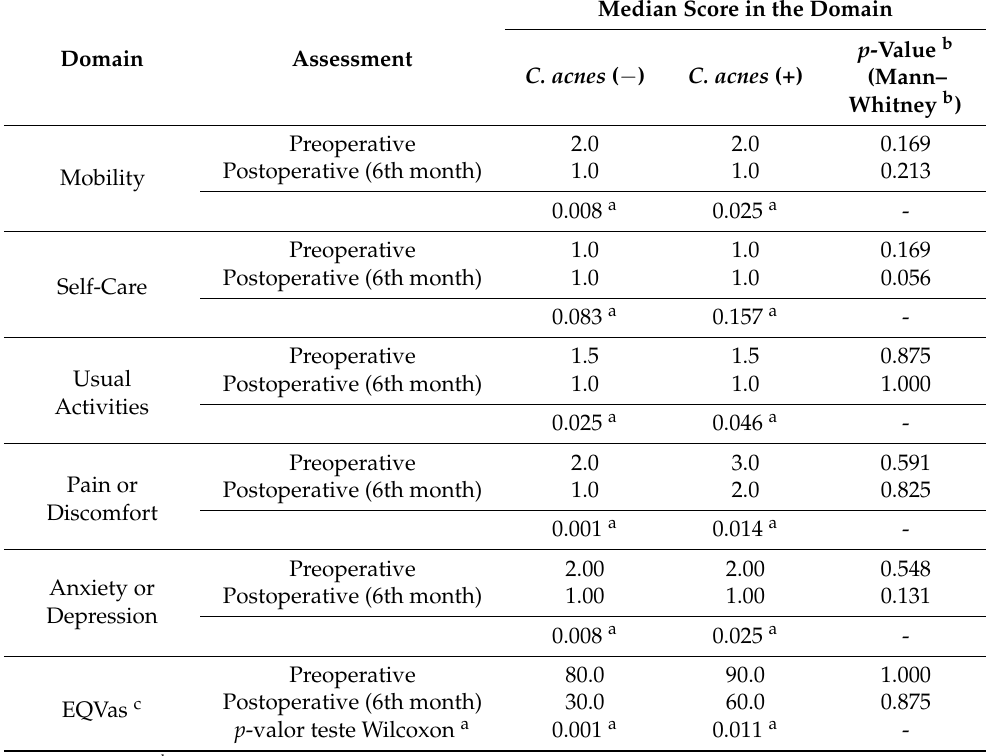
Table 6. EQ-5D Quality of Life